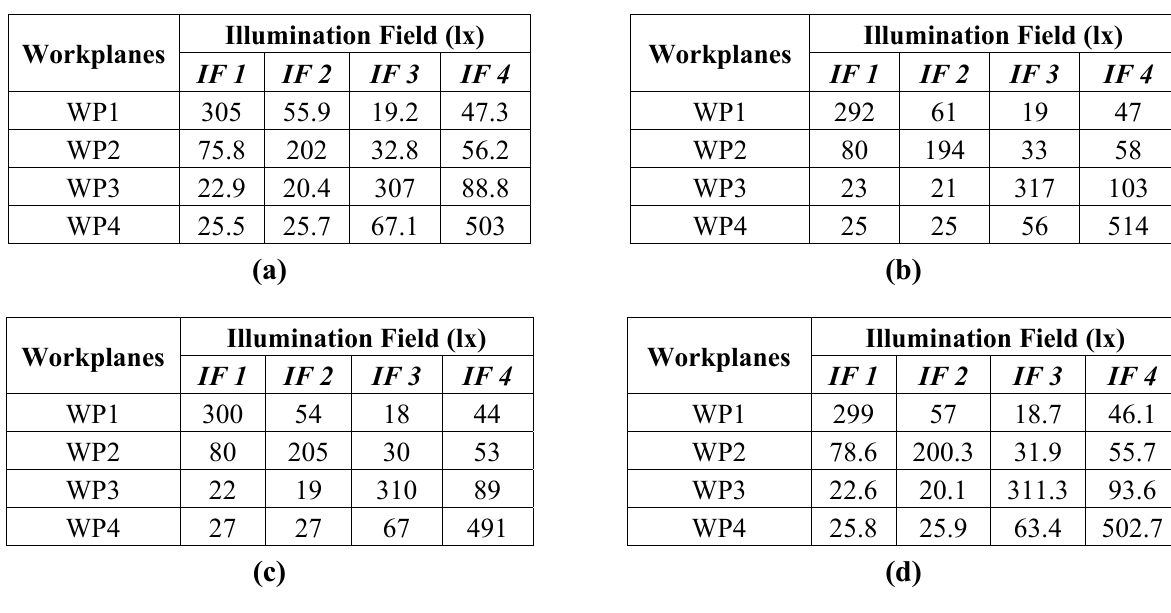
Table 3. Lighting effect dependency tables for multipoint